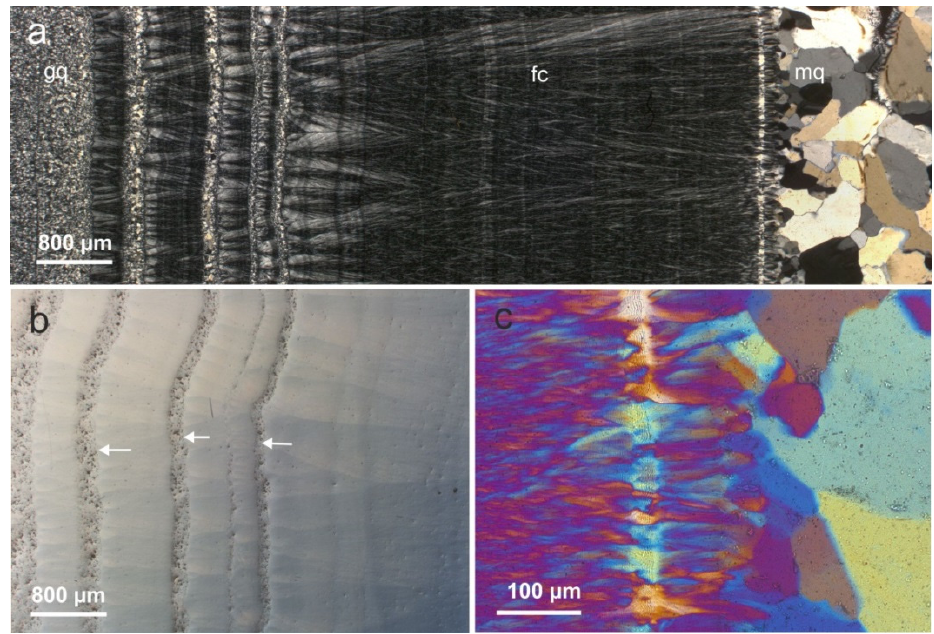
Figure 5. The X-ray diffraction pattern of sample ACub3 (powder sample, background corrected); search-match results in stick patterns: magenta, opal-CT (PDF 00-066-0177); light blue, moganite (PDF 01-073-2991); green, quartz (PDF 01-070-3755); red, calcite (PDF 01-083-0577). The arrows point to the characteristic broad maxima of moganite and opal-CT.